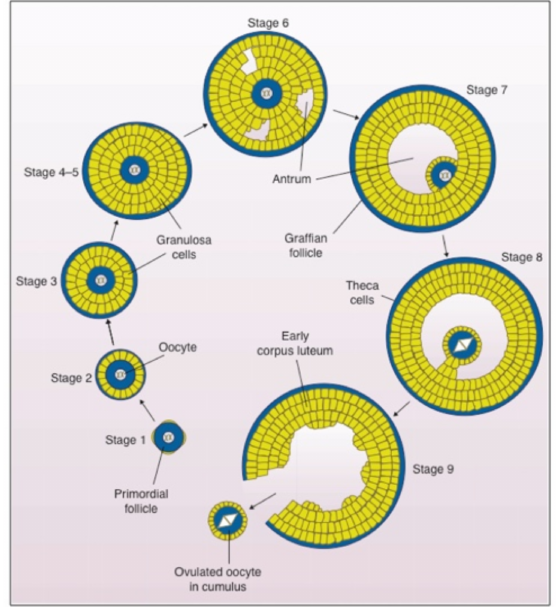
Figure 1. Stages of follicular growth in mammals. Follicular growth begins with stage-1 primordial follicles in the ovary, which consists of a non-growing oocyte (blue) surrounded by a few epithelial- like somatic cells (yellow). As growth is initiated in stage-2 follicles, the somatic cells or granulosa cells (yellow) become cuboidal. During stages-3–5, the granulosa cells proliferate while the oocyte continues to increase in diameter and lays down a thin ZP (blue; outermost layer) that continues to thicken throughout oocyte growth. In stage-6, a fluid-filled cavity or antrum begins to form and by stage-8 the antrum is complete. Surrounded by a relatively thick ZP, the fully grown oocyte sits at the end of a stalk of granulosa cells and is surrounded by several layers of cumulus cells (yellow; stage-8). At stage-9, the fully grown oocyte (blue), which has arrested at metaphase II of meiosis, is ovulated into the oviduct surrounded by cumulus cells (yellow). The follicle that is left behind becomes an endocrine gland, the corpus luteum, that supports pregnancy. In female mice it takes ≈ 2–3 weeks for this developmental process to be completed. This figure is adapted from [14], Figures 2–9, with permission from Cambridge University Press, CSIRO